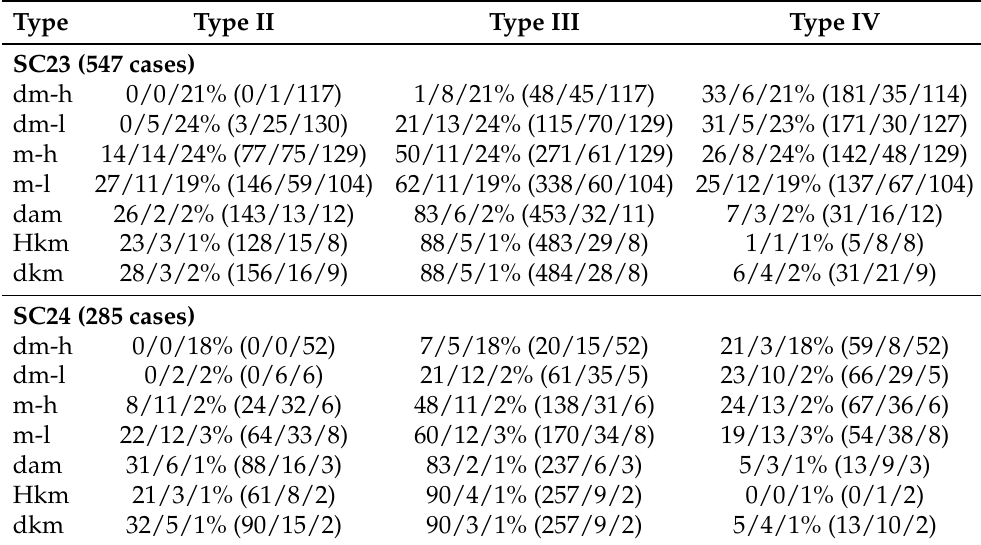
Table 3. Table of the occurrence of radio burst types II, III and IV in the different wavelength ranges for SC23 (normalized to 547 events) and SC24 (to 285, respectively). The results are shown as: visually identified/uncertain associations with observatory reports/data gaps, in % and the exact numbers are given in parentheses. The round-off error is (cid:46)